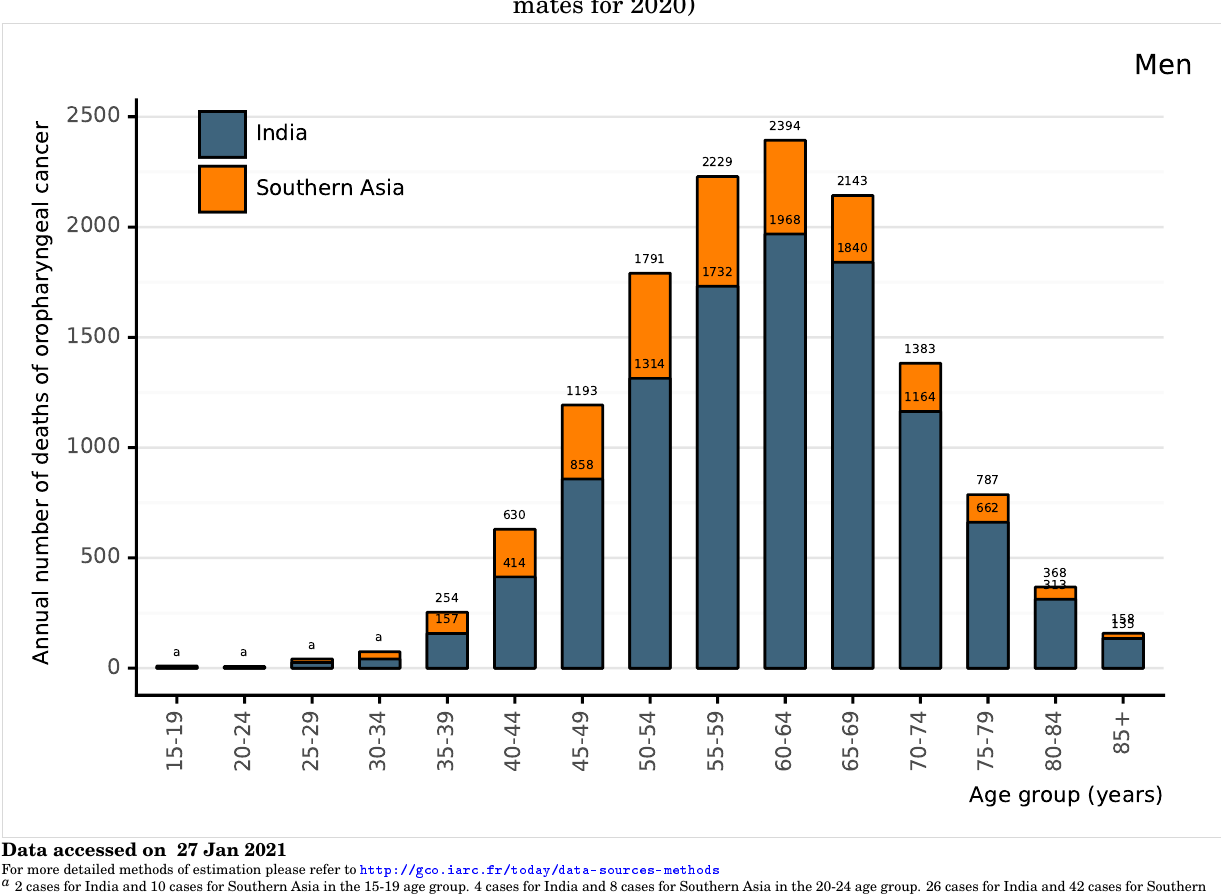
Figure 123: Annual number of deaths of oropharyngeal cancer among men by age group in India